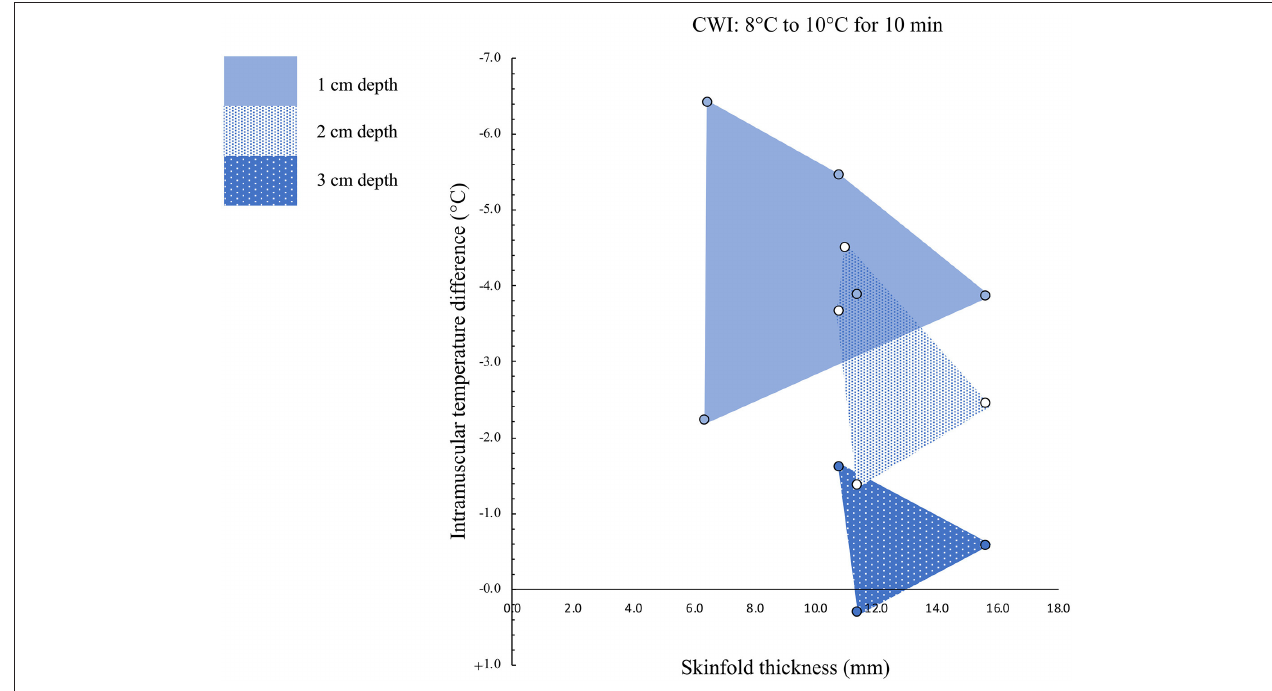
FIGURE 4 | Intramuscular temperature changes in relation to the skinfold thickness. Muscle temperature was measured at depths of 1, 2, and 3cm.